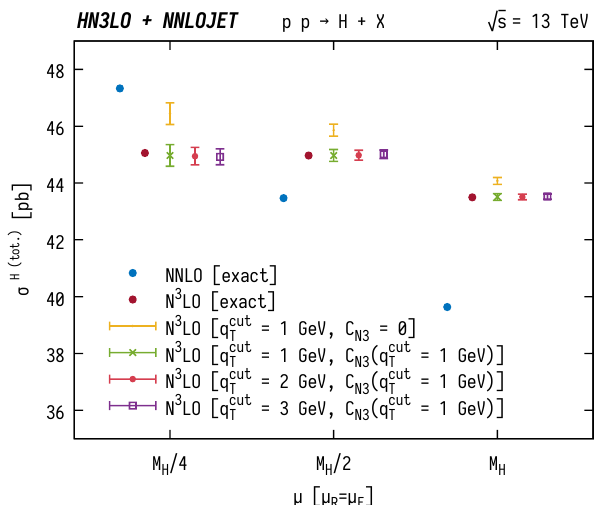
Figure 3 . Total cross section of Higgs boson production, (cid:27) H (tot.) formalism, compared with the corresponding analytical (cid:27) H (tot.)